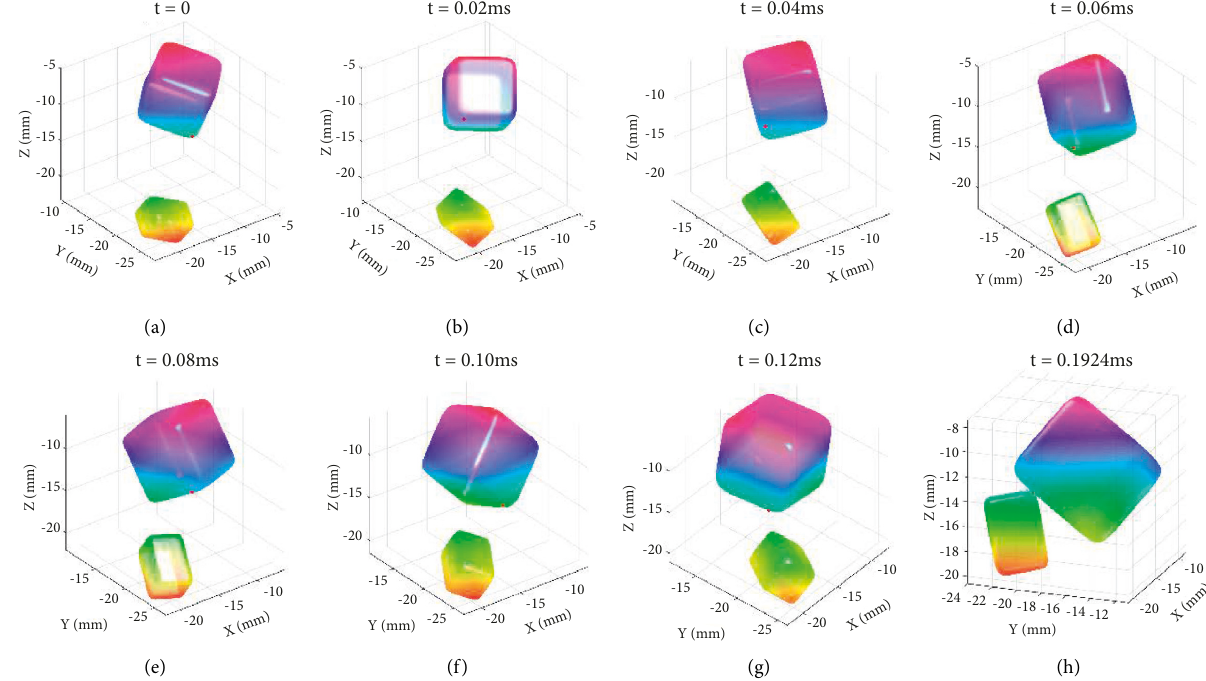
Figure 17: Collision process of two superellipsoids. (a) t � 0s. (b) t � 0.02ms. (c) t � 0.04ms. (d) t � 0.06 ms. (e) t � 0.08ms. (f) t � 0.10ms. (g) t � 0.12ms. (h) t �